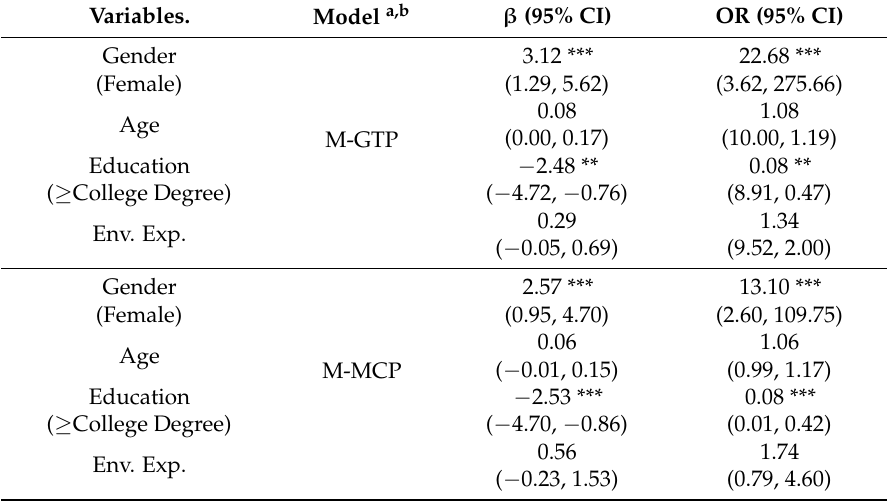
Table A4. The association between food environment exposure and overweight status analyzed by the binary logistic regression models with the food environment exposure measured by the other four widely used